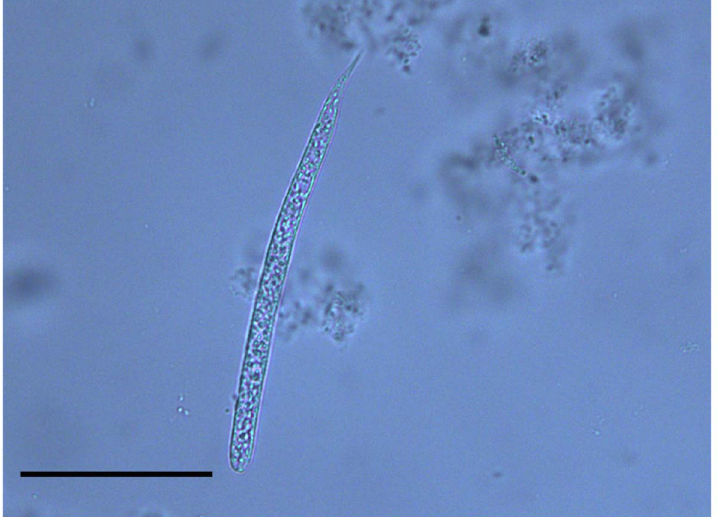
Figure 1. Microfilaria of Onchocercalupi . Microfilaria of Onchocerca lupi found in the skin sediment of a dog (Scale bar: 50 m m). doi:10.1371/journal.pntd.0002585.g001 PLOS Neglected Tropical Diseases |